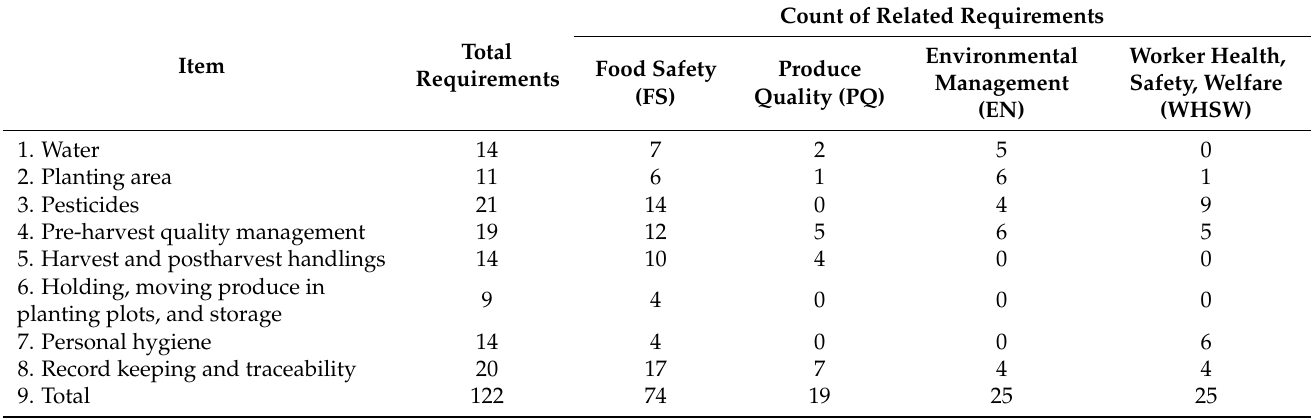
Table 1. Q-GAP requirements for food crops for each production aspect and its relation to the four modules under Thai Agricultural Standard (TAS 9001-2013) on good agricultural